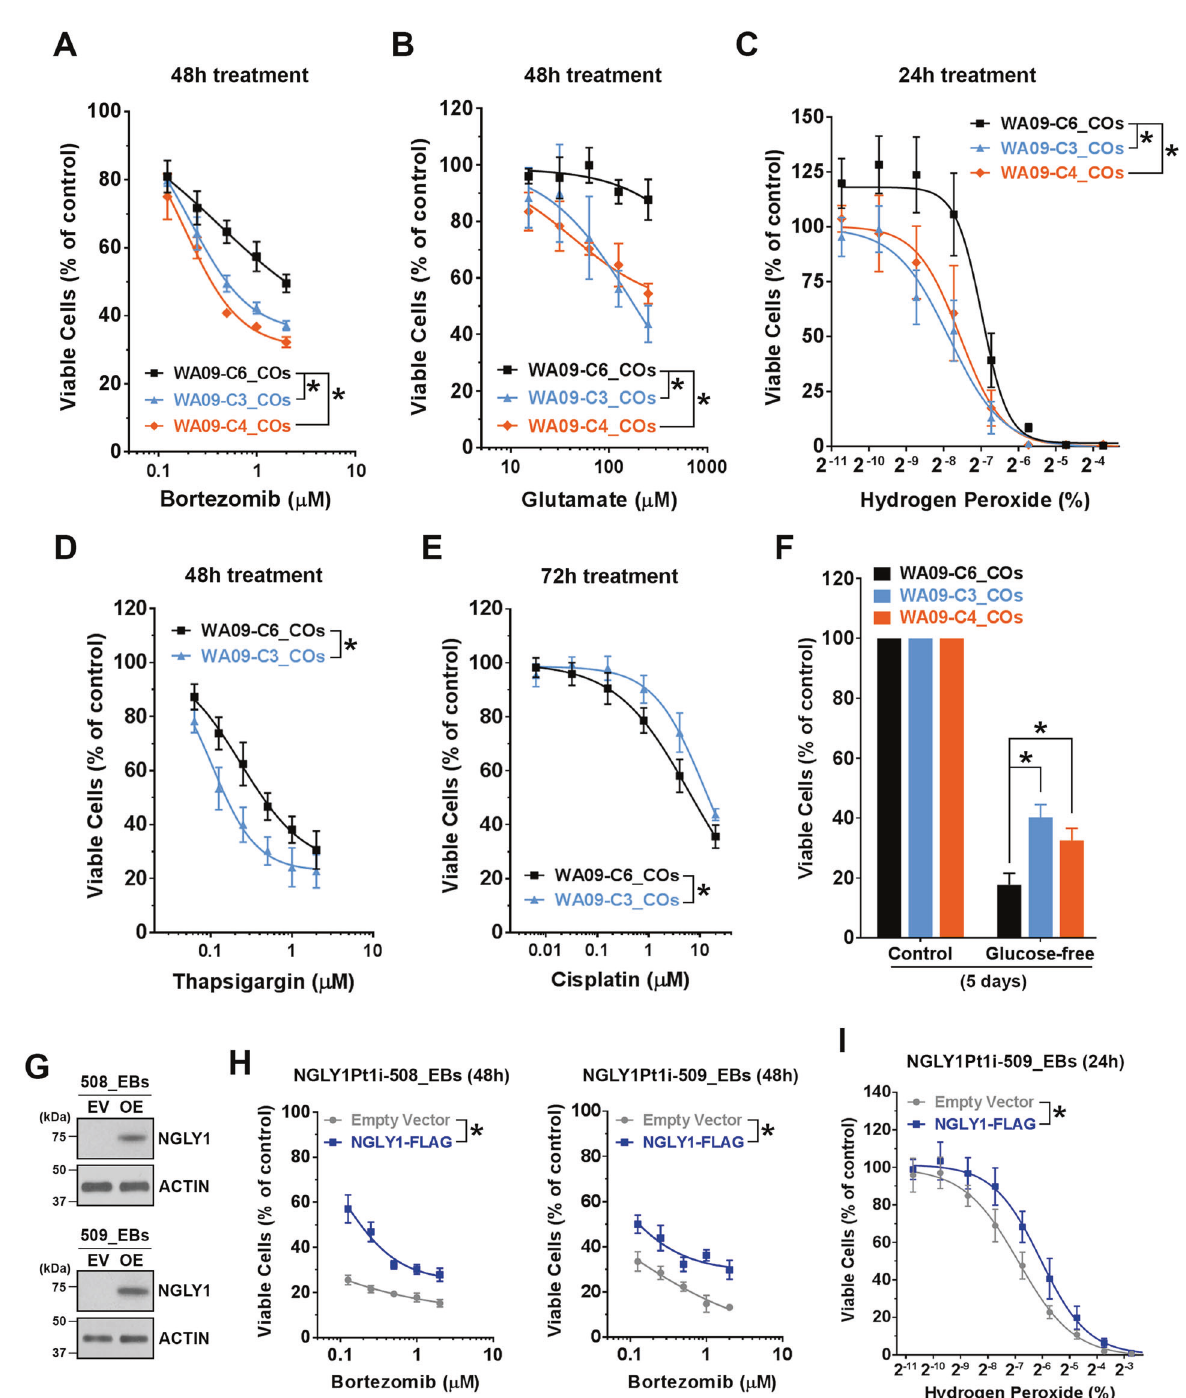
Fig. 3 Microarray-based gene expression pro fi ling reveals the propensity for premature differentiation in NGLY1-de fi cient COs compared with NGLY1-functional COs. A The expression pattern of the NGLY1 gene transcripts in WA09-P and WA09-C6 COs ( n = 4) at six time points during 80-day development. Inset: The relative expression of NGLY1 protein detected by western blotting with densitometry analysis in WA09-C6 COs at the indicated time points. B Genes that were differentially expressed ( p < 0.05, fold change ≥ 1.7) in NGLY1- functional and -de fi cient COs at the indicated time points for sample collection were highlighted in blue in the volcano plots of fold change vs. statistical signi fi cance. C The differential expression of NEUROD2 detected by western blotting with densitometry analysis in NGLY1- functional and -de fi cient COs with 65 days (D65) of development. * p < 0.05, t -test. D The relative expression of ATF4 and GADD153 detected by western blotting with densitometry analysis in NGLY1-functional and -de fi cient COs and MALME3M_shRNA645 melanoma cells with doxycycline-induced knockdown of NGLY1. C6: NGLY1-functional COs. C3: NGLY1-de fi cient COs. Thap: 24-h treatment of 0.5 µM thapsigargin. * p < 0.05, t